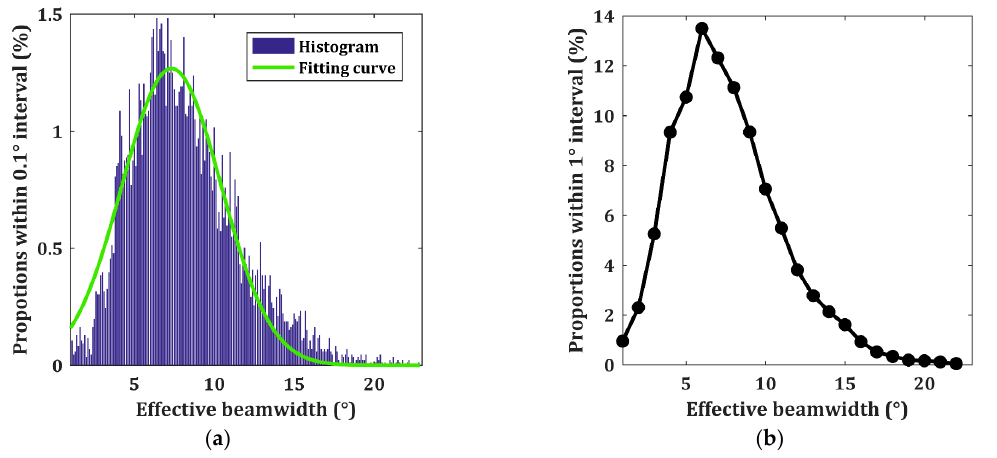
Figure 12. The distributions of the proportions of effective beamwidth to total Tomoradar measurements within a window from 1° to 23° and each section of different intervals. ( a ) 0.1° interval; ( b ) 1° interval.